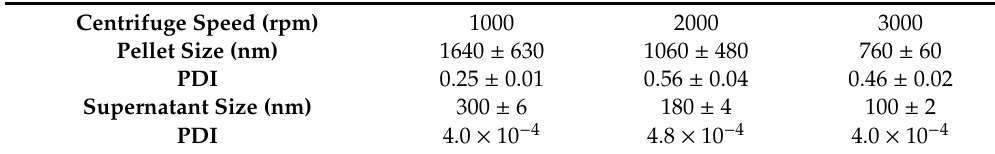
Table 1. MgO particle sizes for a range of centrifuging speeds. The polydispersity index (PDI) for each measurement is also shown in the table.